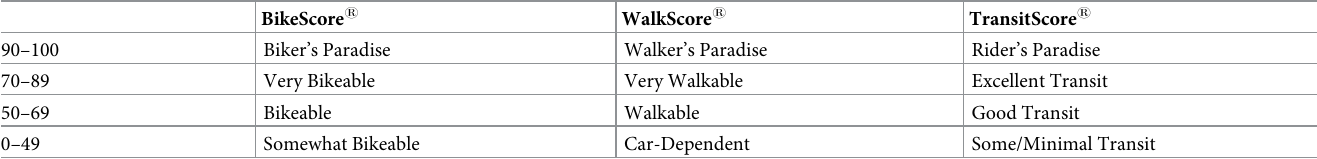
Table 7. Description: BikeScore 1 , WalkScore 1 , and TransitScore 1 .